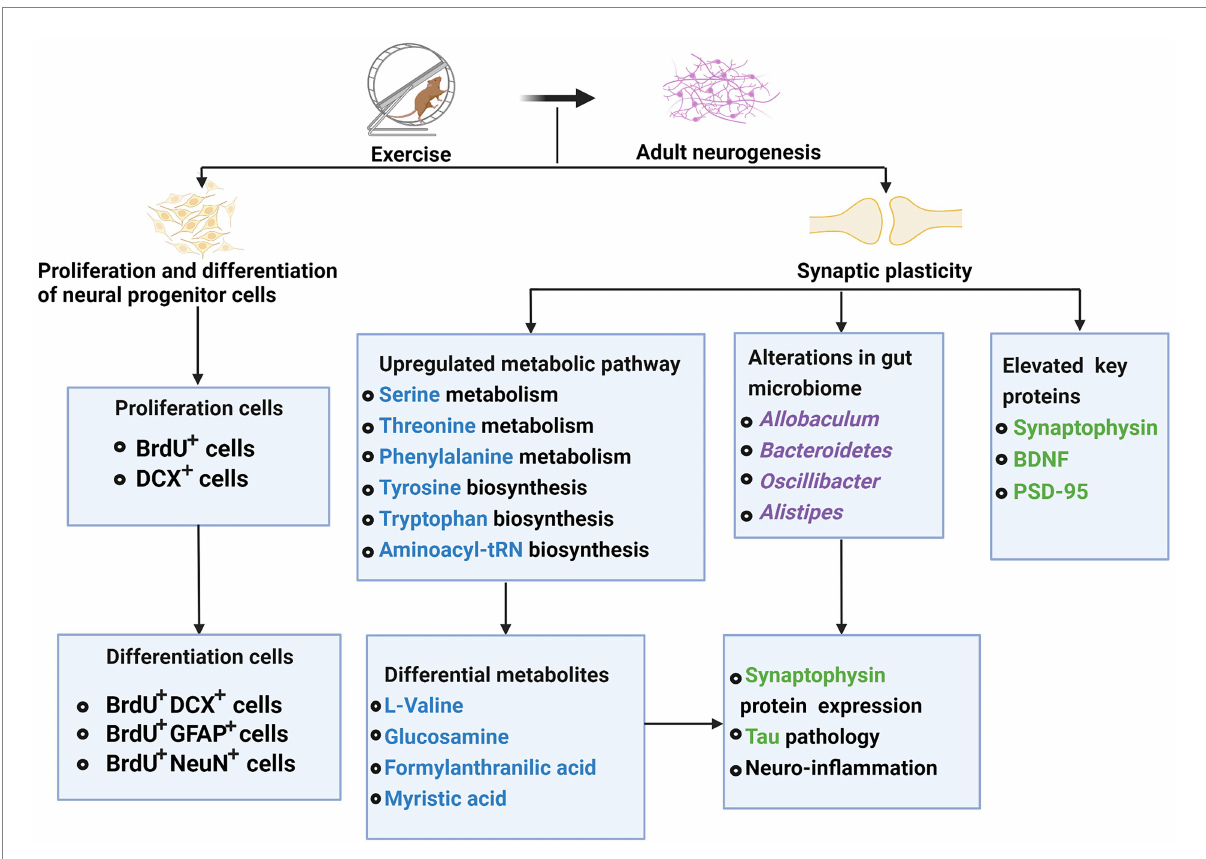
FIGURE 2 Effects of exercise on adults’ neurogenesis in neurodegenerative